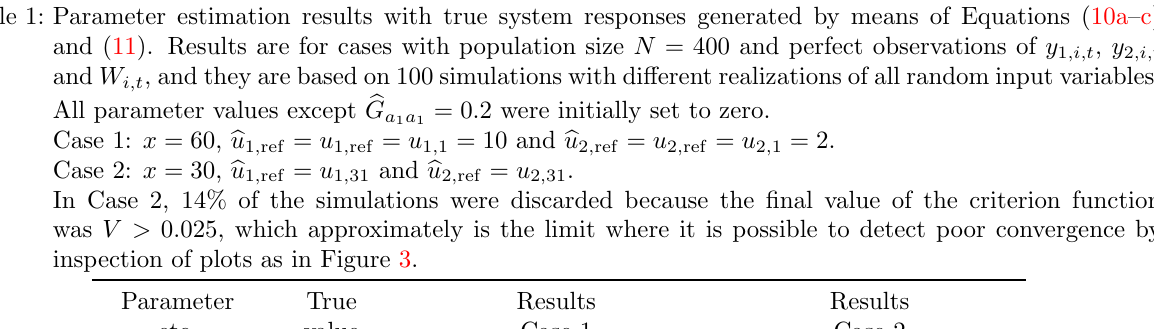
Table 1: Parameter estimation results with true system responses generated by means of Equations (10a–c) and (11). Results are for cases with population size N = 400 and perfect observations of y 1 ,i,t , y 2 ,i,t and W i,t , and they are based on 100 simulations with different realizations of all random input variables. All parameter values except (cid:98) G a = 0 . 2 were initially set to zero. 1 a 1